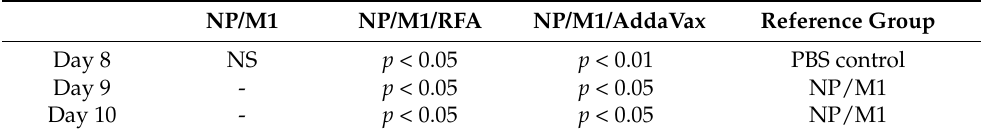
Figure 5. Protection against body weight loss after lethal viral challenges. Mice were intranasally challenged with 4 × LD50 of mouse-adapted PR8 viruses 28 days after boost. Body weight loss was monitored daily for 14 days. n = 5.